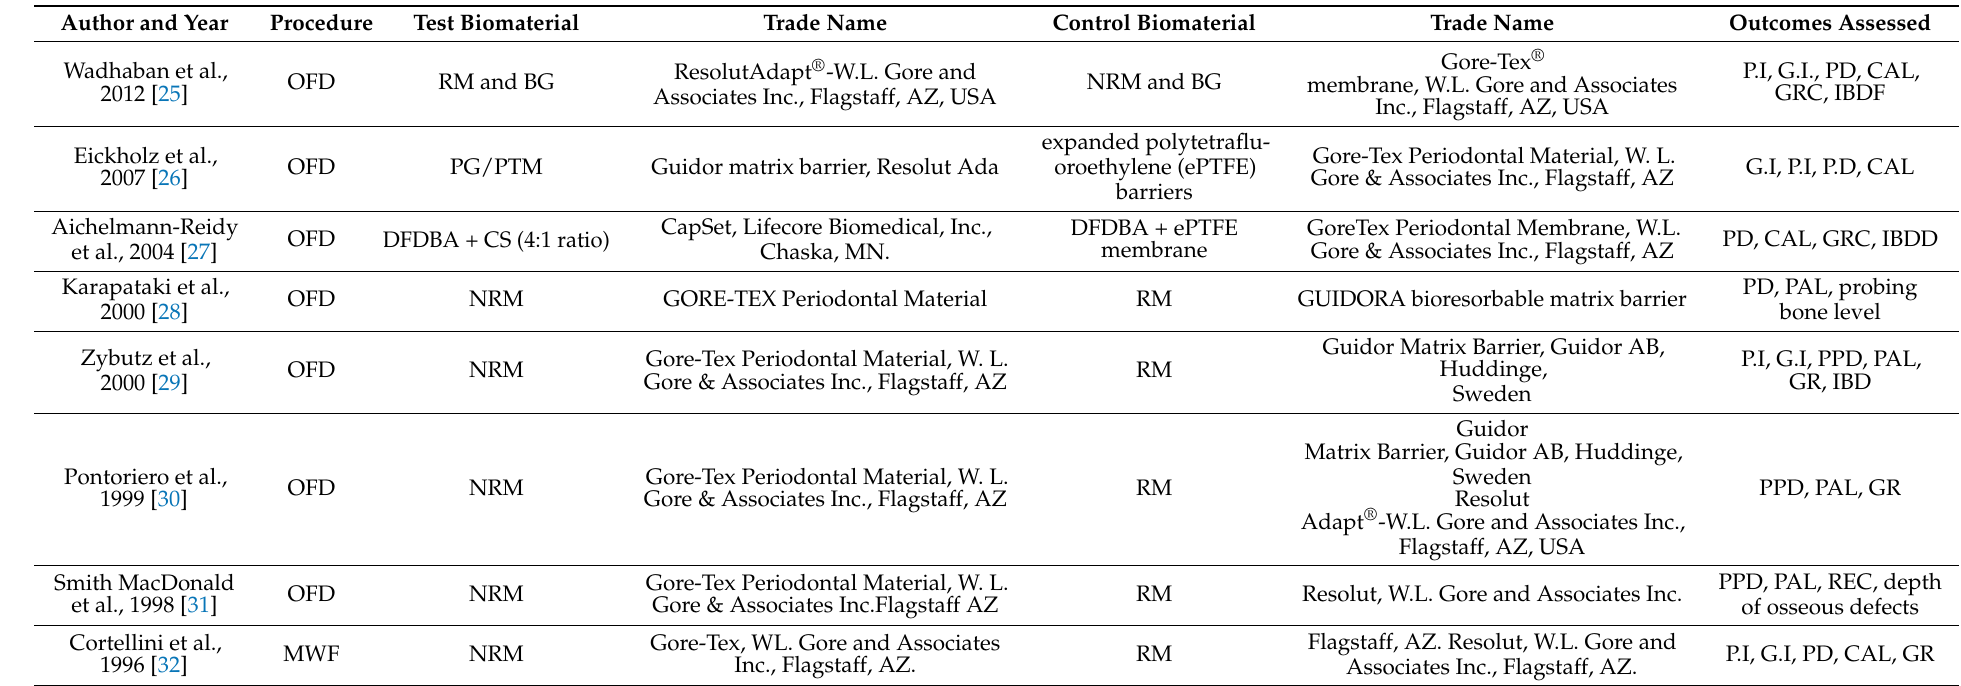
Table 2. Interventional characteristics of the included